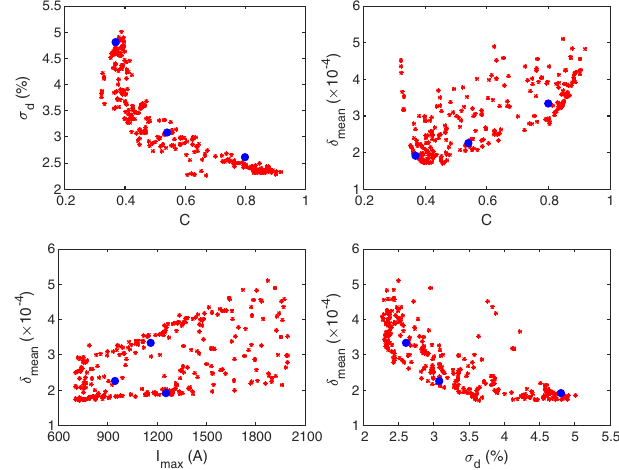
FIG. 4. Projection of the Pareto-optimal front obtained by the NSGA-III on different planes. The three blue dots are three typical solutions whose current profiles and longitudinal phase spaces are presented in Fig.